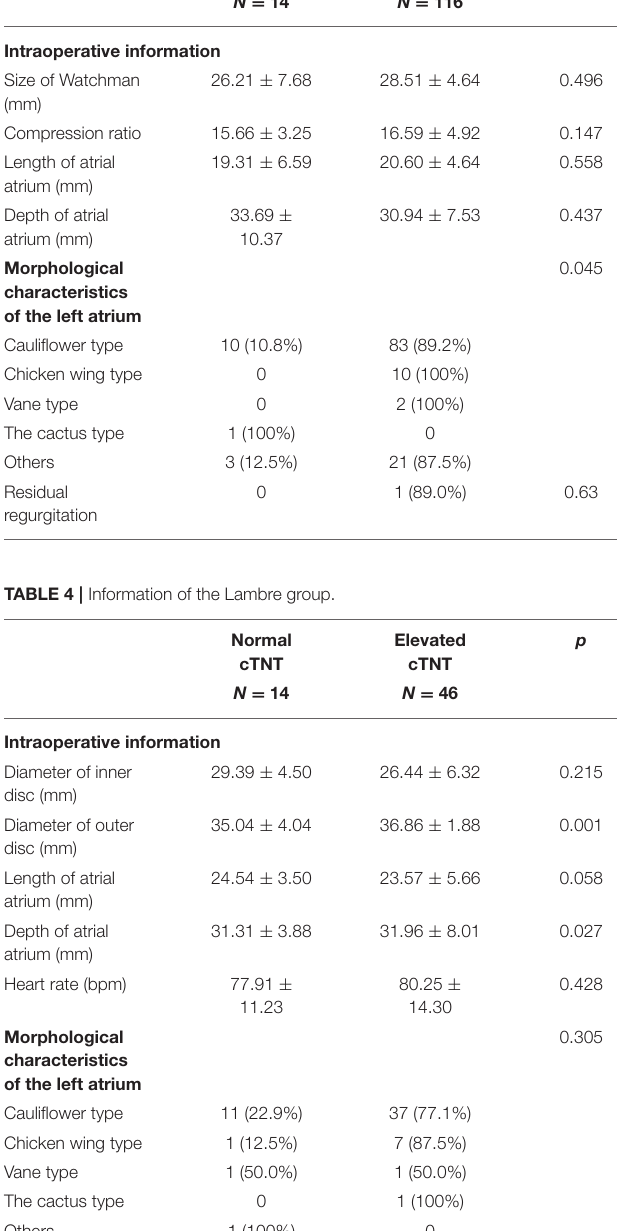
is not as high as that of the Watchman, but the outer disk size and atrial diameter of the Lambre device are accountable for the degree of myocardial